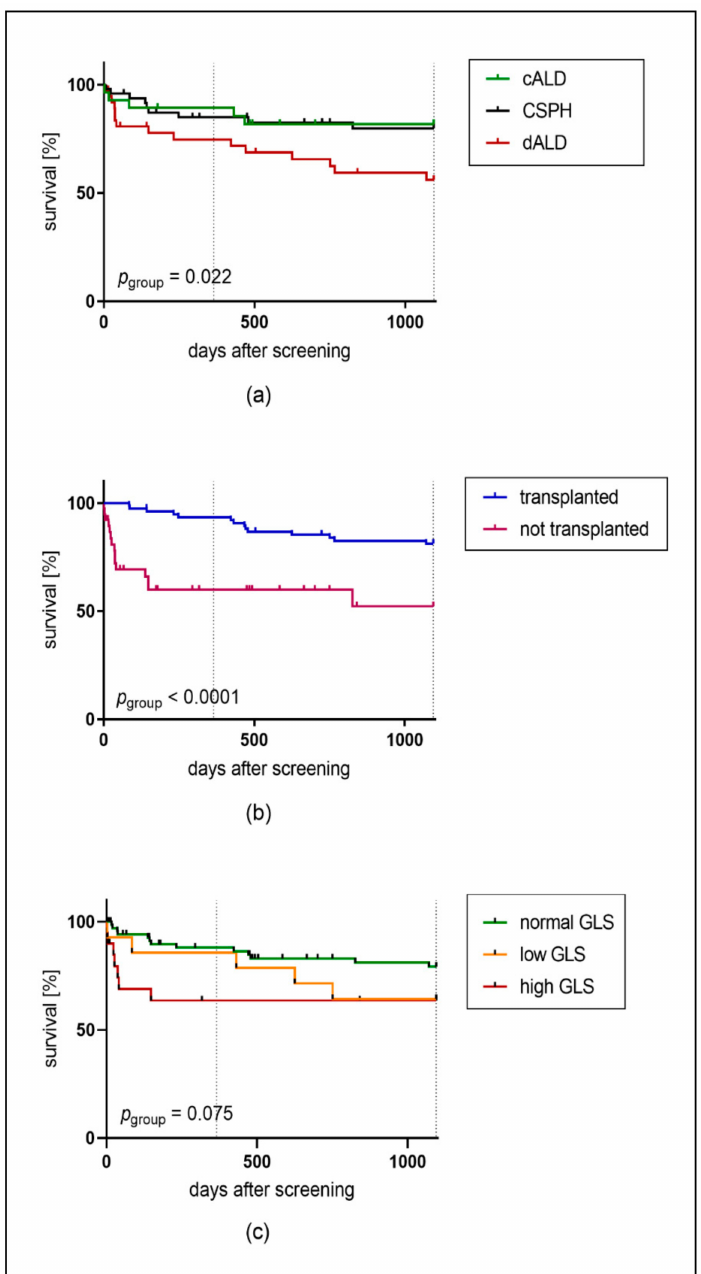
Figure 3. Kaplan-Meier survival curves: survival probability was displayed according to ( a ) liver disease groups, ( b ) liver transplantation and ( c ) global longitudinal strain (GLS) categories. Cox regression identified dALD (odds ratio (OR), 2.758; p = 0.048), MELD score, (OR, 1.145; p < 0.001), GLS category at rest (OR, 2.614; p = 0.033), body mass index (OR, 0.898; p = 0.041), and transplantation (OR = 0.277; p = 0.001) as predictors of mortality. After multivariate analysis, dALD (OR, 7.561; p = 0.045), MELD score (OR, 1.191, p = 0.001), low GLS at rest (OR, 16.482; p = 0.002), and transplantation (OR, 0.082; p = 0.001) kept a significant e ff ect on mortality (Table